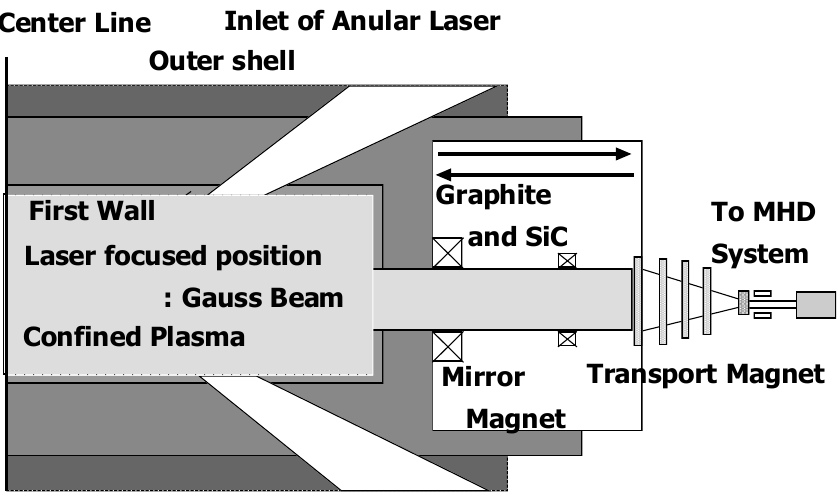
Figure 15. Illustration of the reactor with mirror magnetic field and graphite solid blanket with molten salt